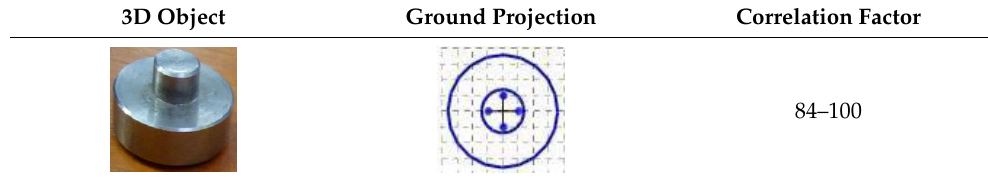
Table 4. Specification of the sensed object.